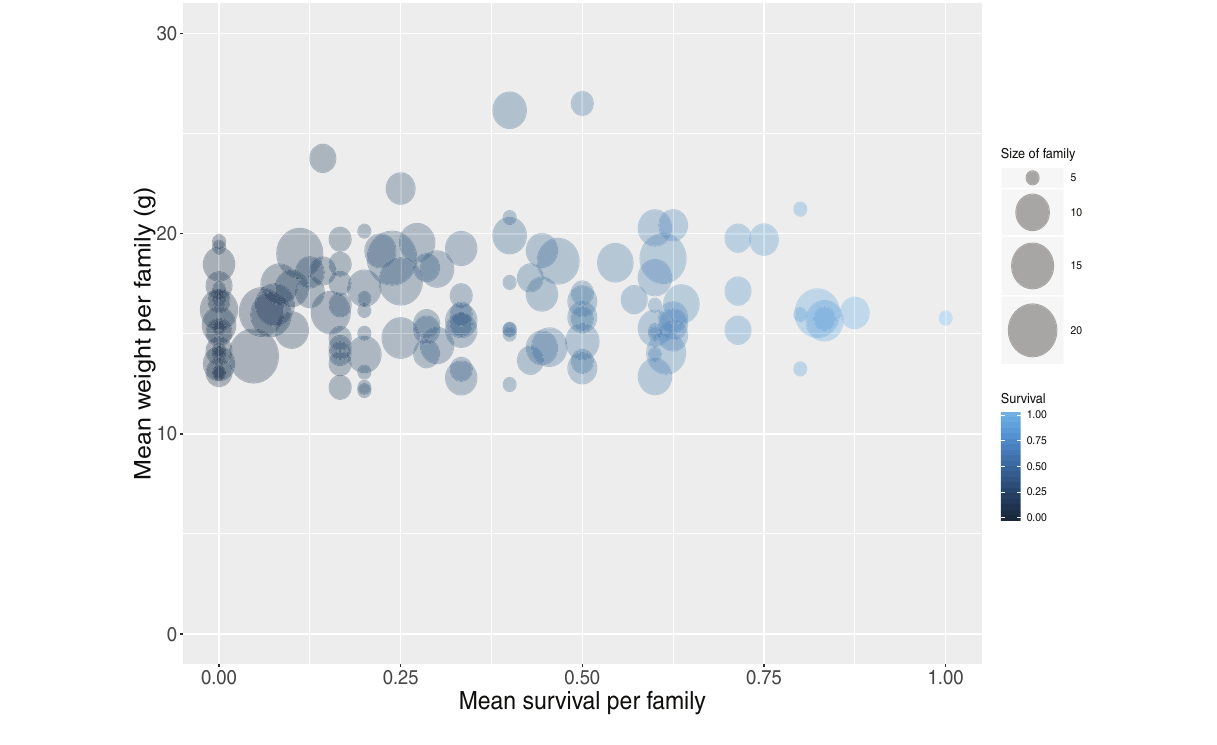
FIGURE 1 | Mean weight and survival for all assigned full-sib